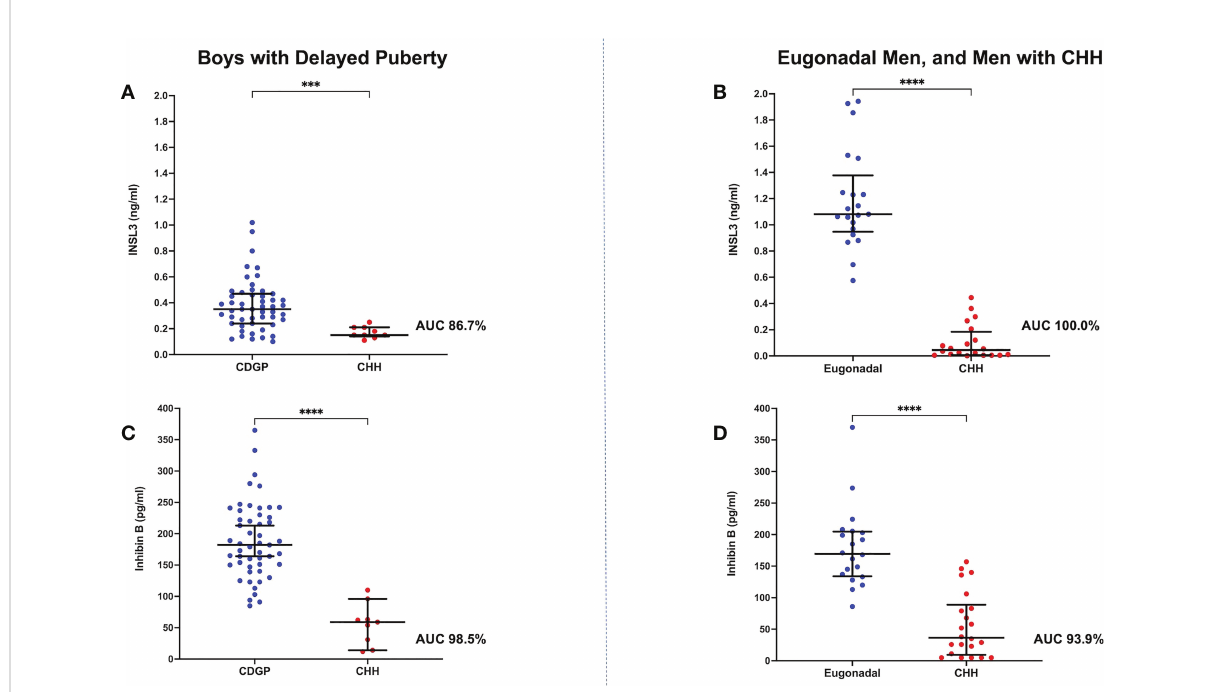
FIGURE 1 (A) Scattergram (median, IQR) of basal INSL3 (ng/ml) in boys with CDGP in blue and boys with CHH in red. Groups were compared using the Mann-Whitney U test (*** p value 0.0002). auROC of 86.7%. (B) Scattergram (median, IQR) of basal INSL3 (ng/ml) in eugonadal men in blue and men with CHH in red. Groups were compared using the Mann-Whitney U test (**** p value <0.0001). auROC of 100%. (C) Scattergram (median, IQR) of basal INB (pg/ml) in boys with CDGP in blue and boys with CHH in red. Groups were compared using the Mann-Whitney U test (**** p value <0.0001). auROC of 98.5%. (D) Scattergram (median, IQR) of basal INB (pg/ml) in eugonadal men in blue and men with CHH in red. Groups were compared using the Mann-Whitney U test (**** p value <0.0001). auROC of